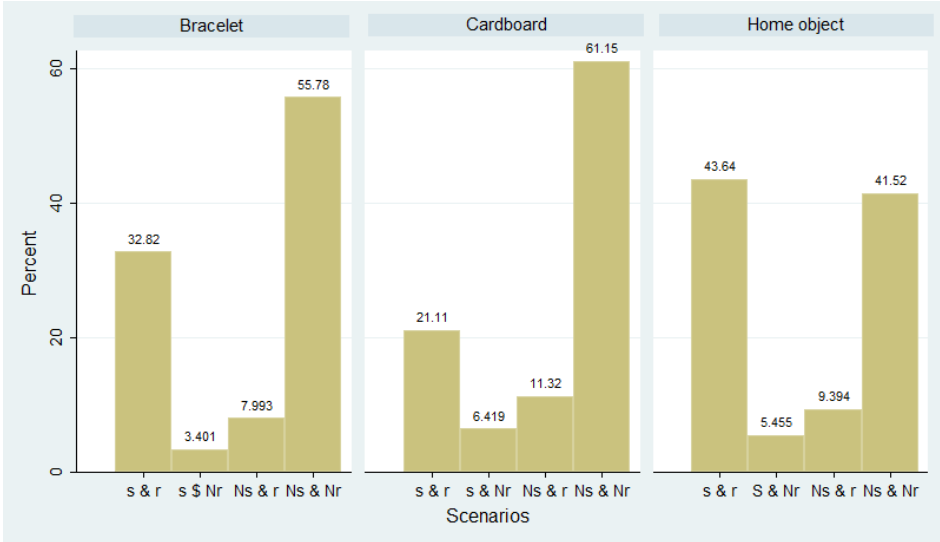
Figure 2. Four scenarios for the tokens.